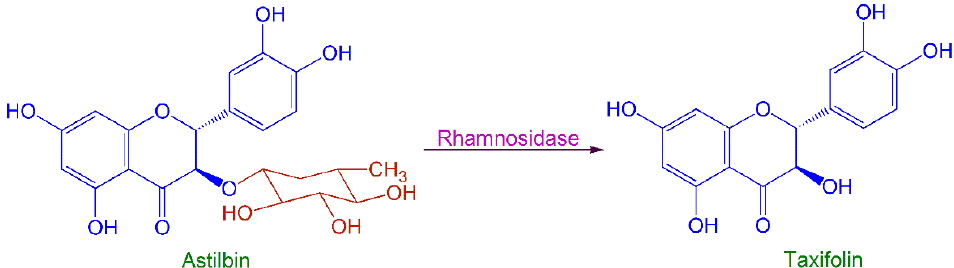
Figure 1. Fungal biotransformation of astilbin to taxifolin.